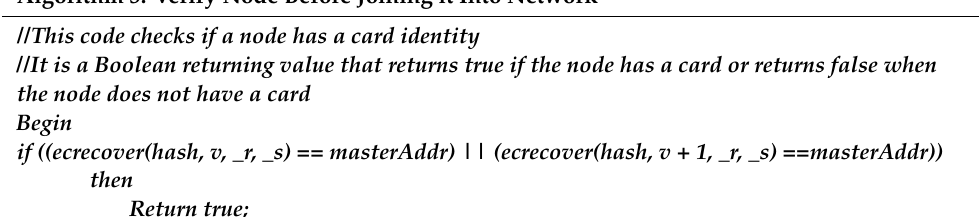
Algorithm 3: Verify Node Before Joining it Into